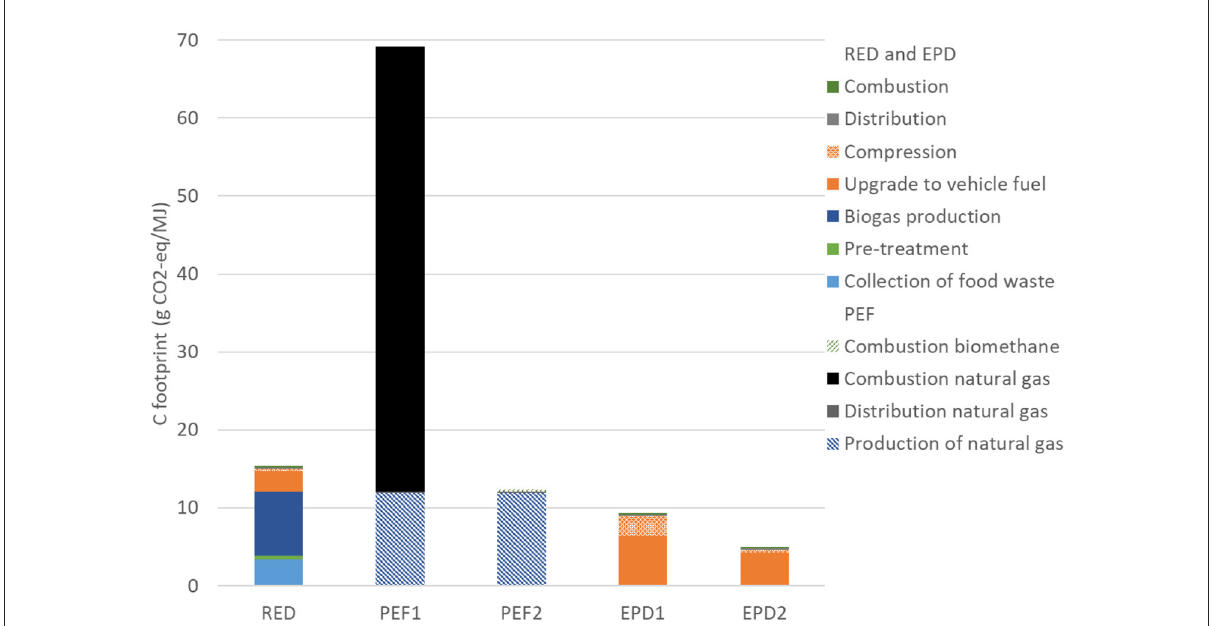
FIGURE6 Carbon footprint of food-waste biogas, as modeled by RED II, PEF, and EPD. PEF results are calculated under the assumption that the biogas substitutes the production and use of natural gas (PEF1, tall bar) or only the production of natural gas (PEF2), EPD results are calculated with two sets of electricity data representing the residual mix for the Nordic region (EPD1) and Sweden (EPD2),